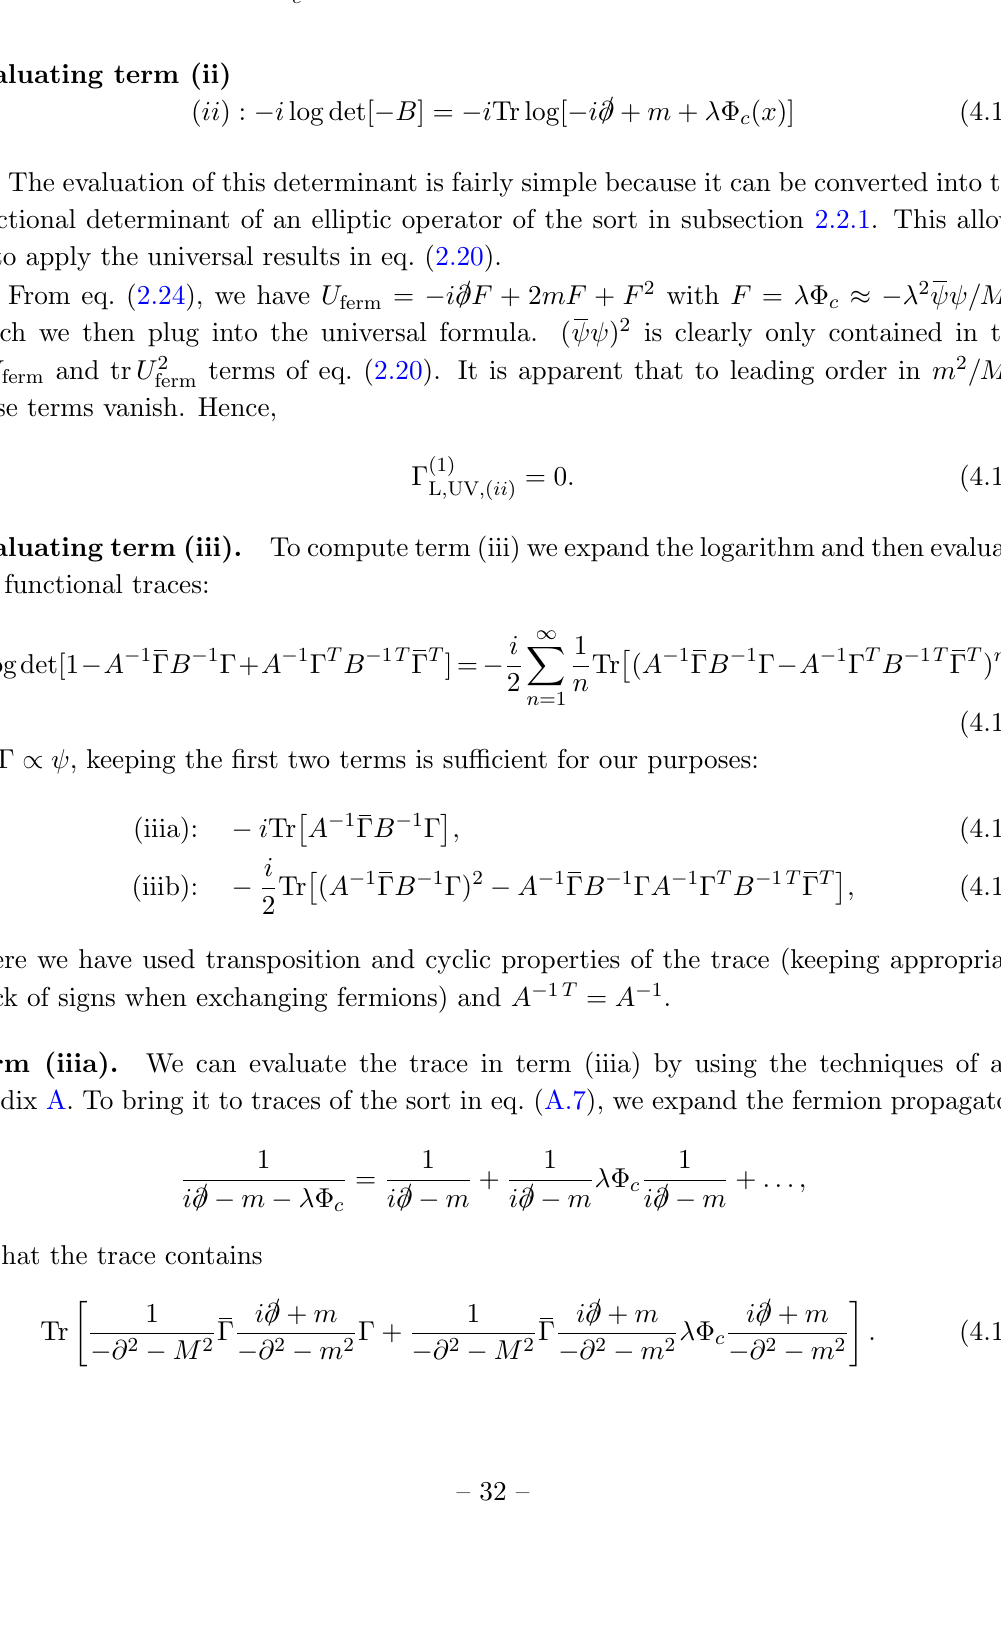
Figure 2 . How the diagrams of (cid:12)gure 1 appear in the functional evaluation of (cid:0) (1) external fermion lines correspond to ; (cid:22) , internal fermions to (cid:14) ; (cid:14) (cid:22) , dashed lines to (cid:14) (cid:8), while the cross denotes an insertion of (cid:8) c